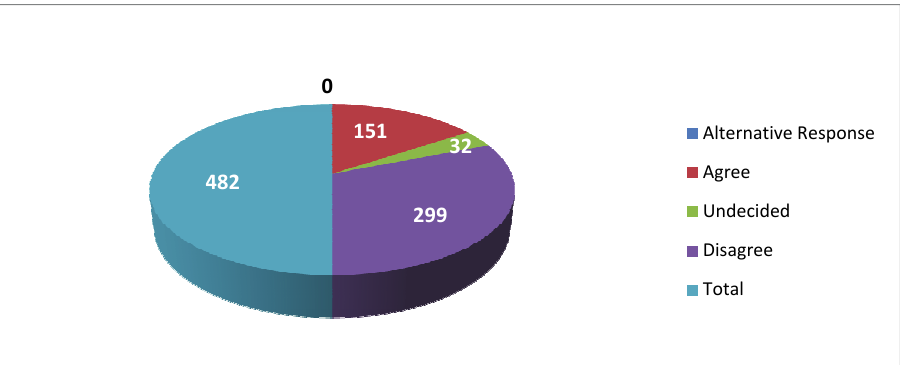
Source: Field Survey July,